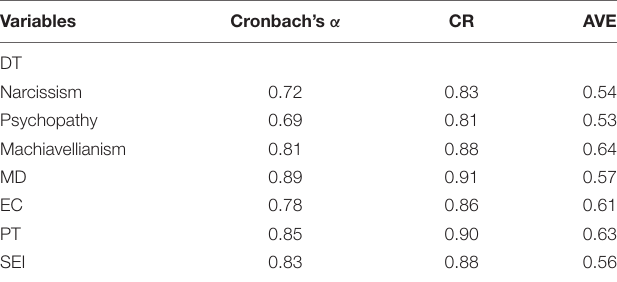
TABLE 4 | Internal reliability and convergent validity of Study